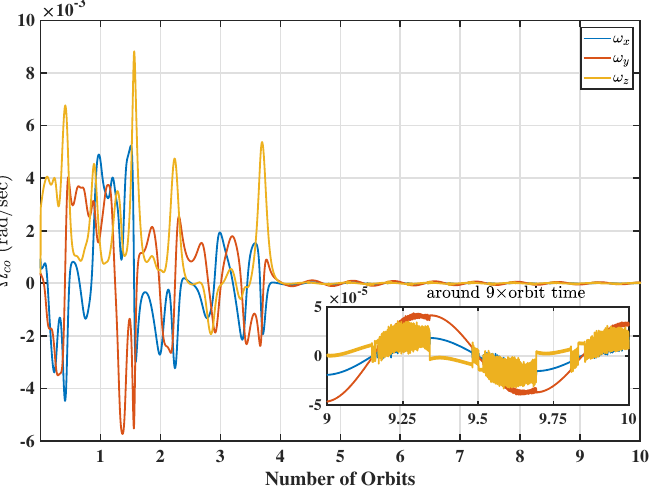
Figure 4. Angular velocities achieve stability (up to an error bound) with initial Ω x = 0.0004 rad/s, Ω Ω y = 0.0004 rad/s, z = 0.0009 rad/s, despite an almost time-invariant magnetic field.